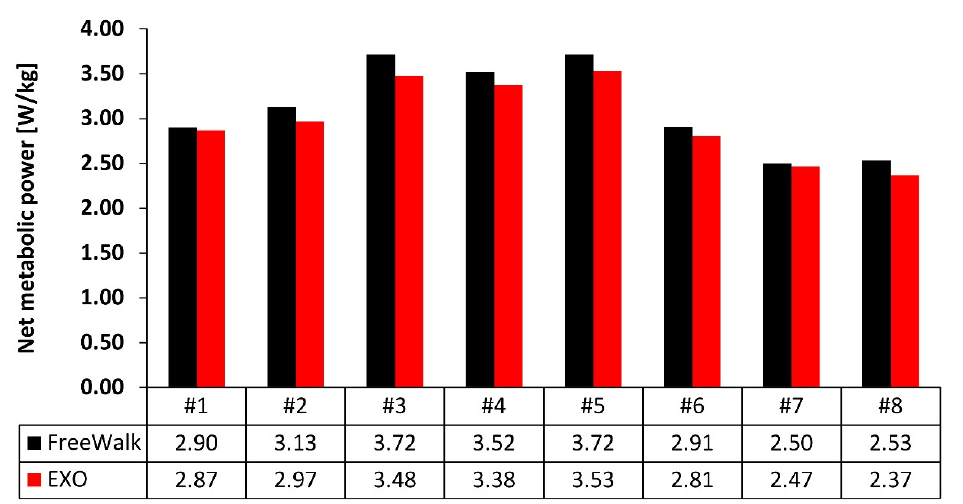
Figure 4. Net metabolic power for each participant during the two conditions of testing. FreeWalk condition (black) and EXO condition (red). Table 1. Spatio-temporal parameters for the two conditions of testing. Data are presented as means ±